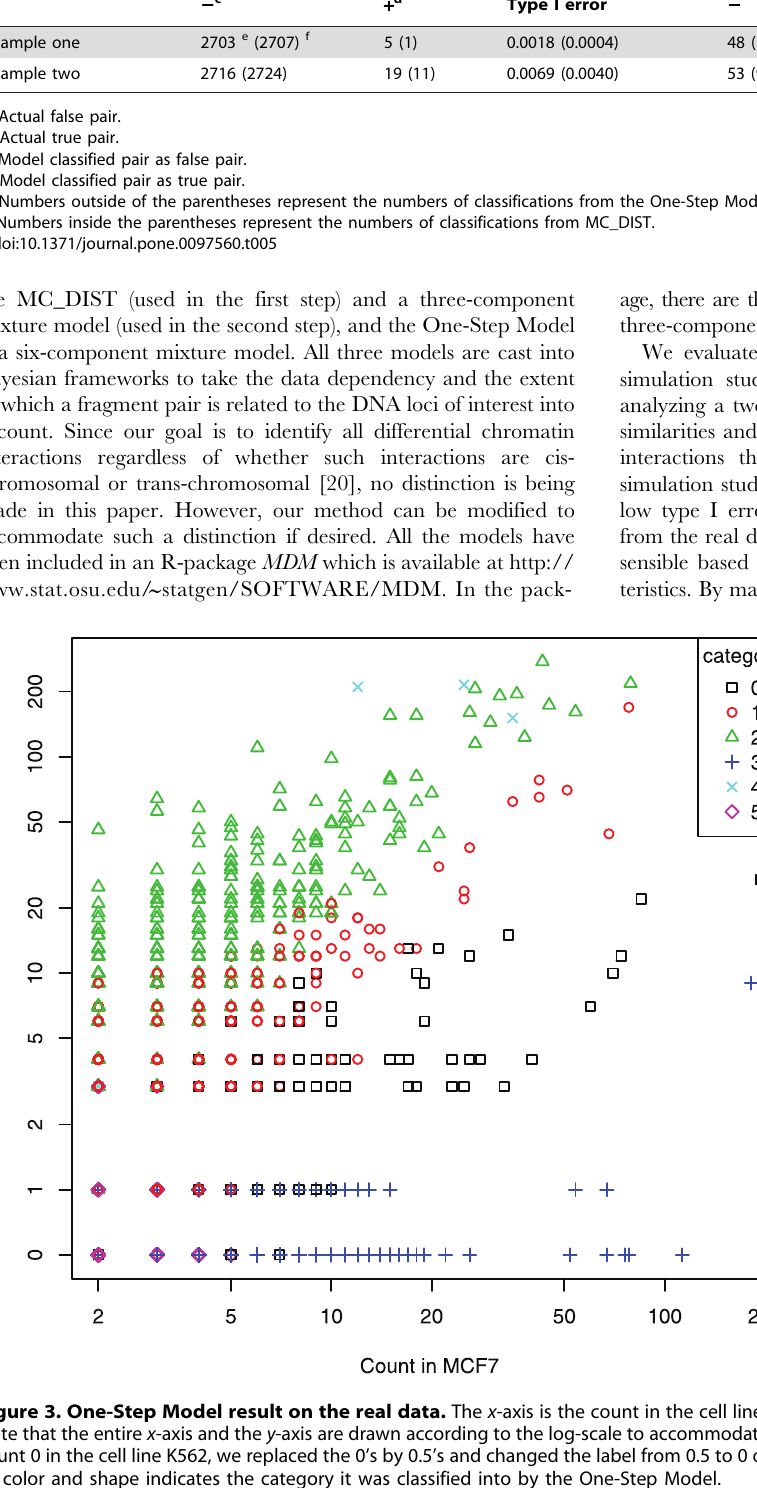
Actual 2 a + b 2 c + d Type I error 2 + Power Sample one 2703 e (2707) f Sample two 2716 (2724)